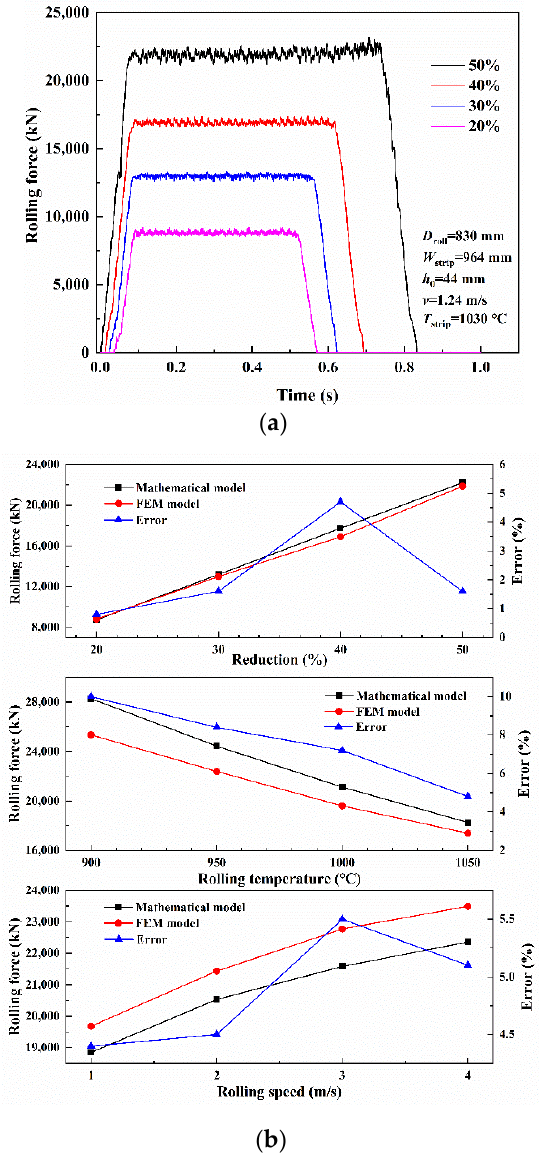
Figure 6. ( a ) Rolling force with time under different reduction, ( b ) comparison of rolling force between the FEM results and mathematical model results.